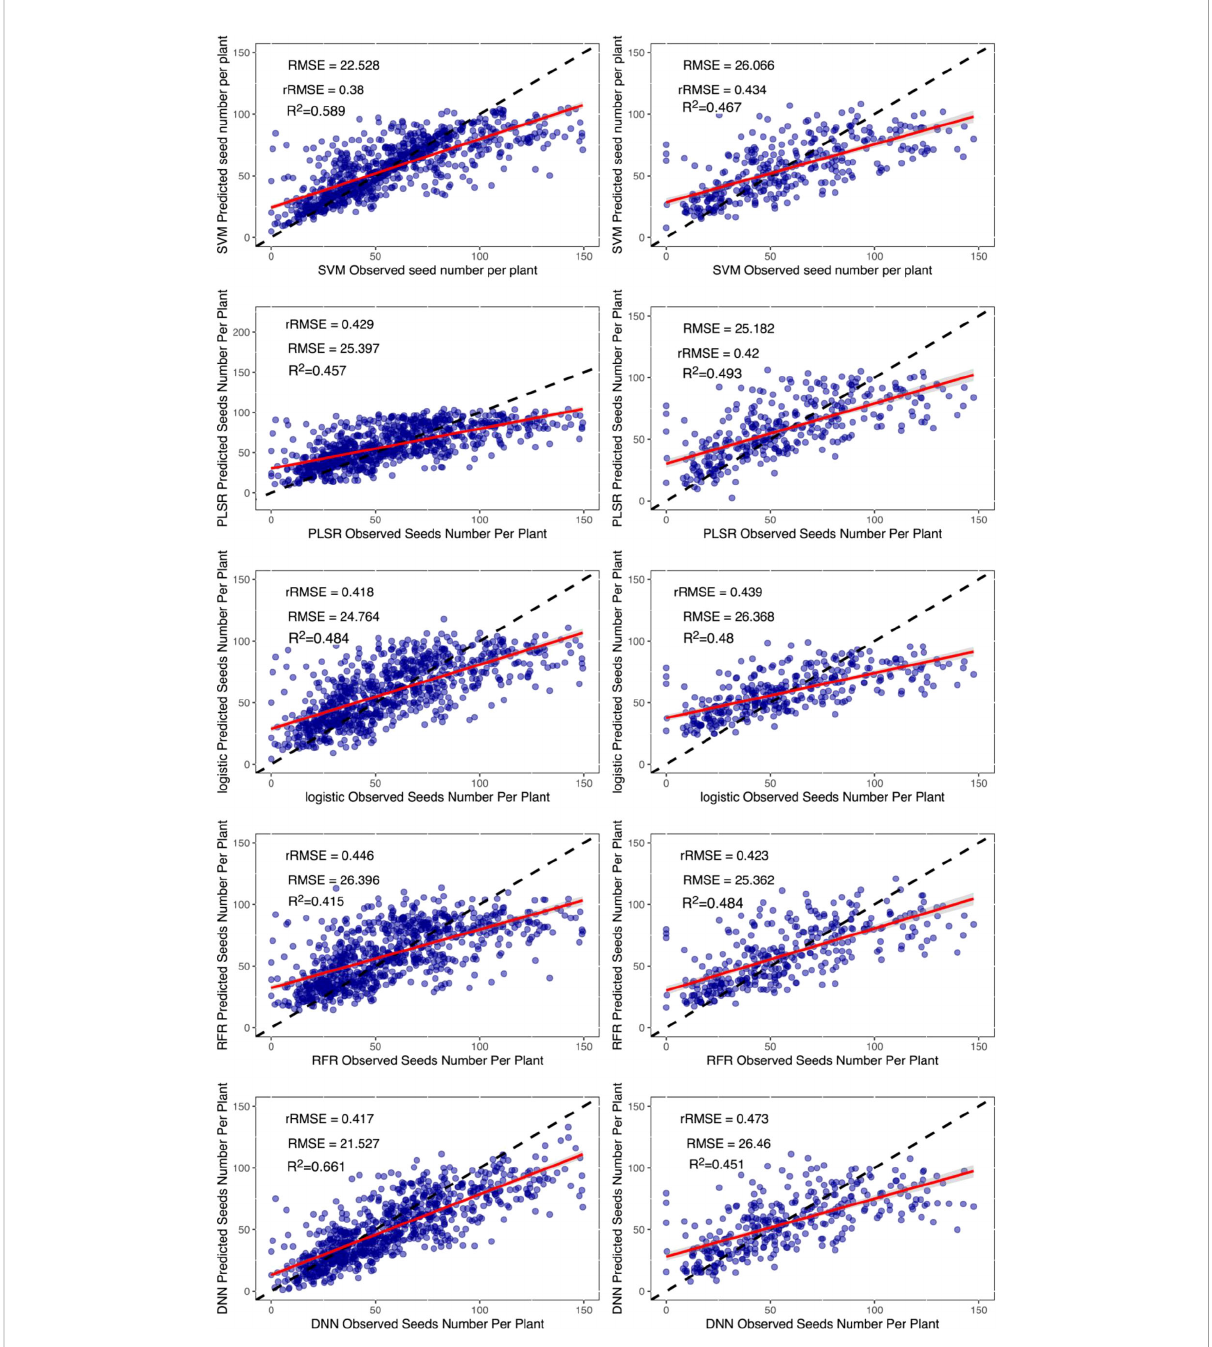
FIGURE 8 Results of machine learning algorithms to estimate the grain number of seeds per plant. The left column is the training dataset, and the right column is the validation dataset. The black dashed line is the 1:1 line, and the red solid line is the data fi tted line. SVM, support vector machines regression; RFR, random forests regression; PLSR, partial least squares regression; Logistic, logistic regression; DNN, deep neural